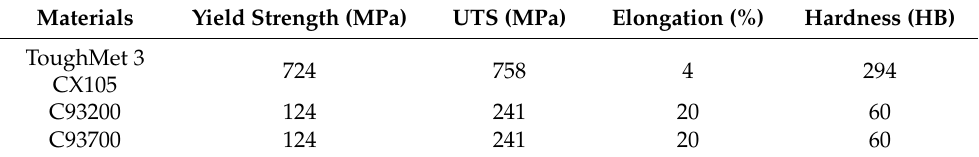
Table 3. Properties of different